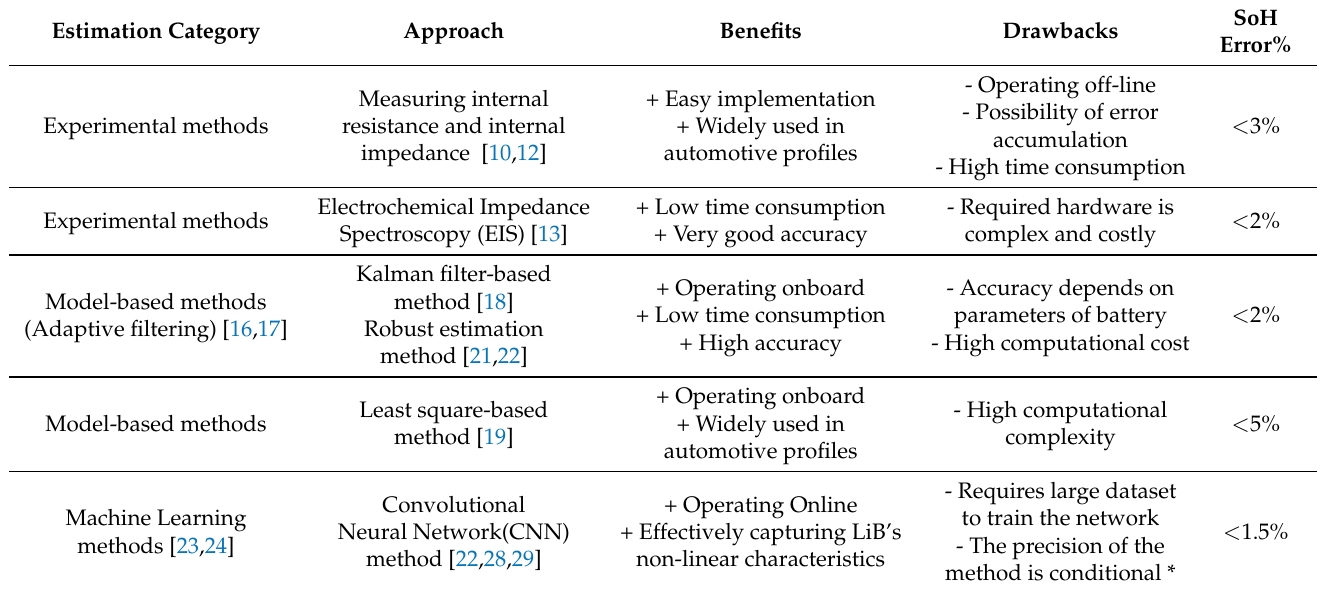
Table 1. A summary of the main studied SoH estimation methods, including their categories, benefits, drawbacks, and